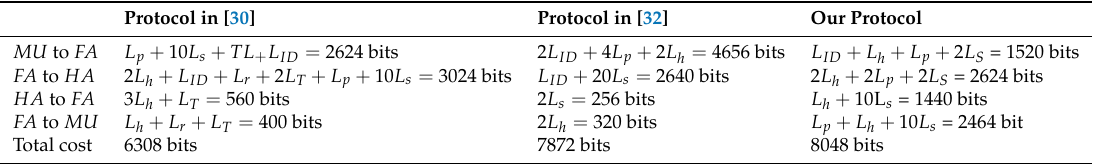
Table 4. Communication cost comparison